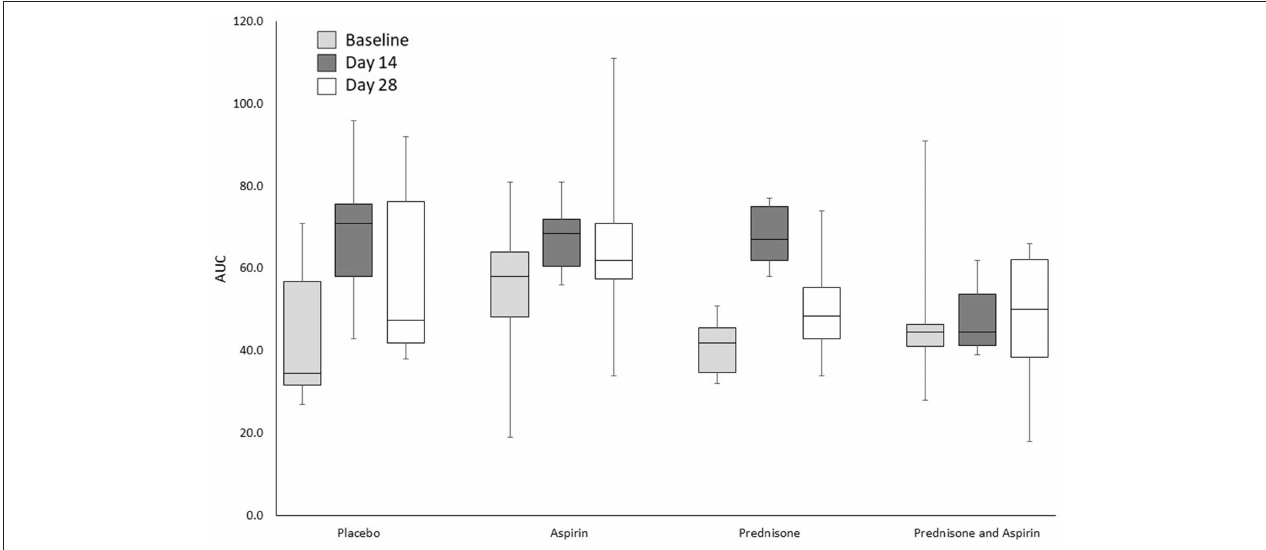
FIGURE 1 | Impedance aggregometry AUCs for 24 healthy dogs administered placebo, aspirin with placebo, prednisone with placebo, or combination prednisone and aspirin therapy for 28 days. There were no significant differences in treatment group or treatment group-by-time interaction, but there was a significantly higher AUC on day 14 compared to baseline ( P < 0.001) and day 28 ( P = 0.048). The box and whiskers plot demonstrate the median (line), interquartile range (box), and total range (whiskers).